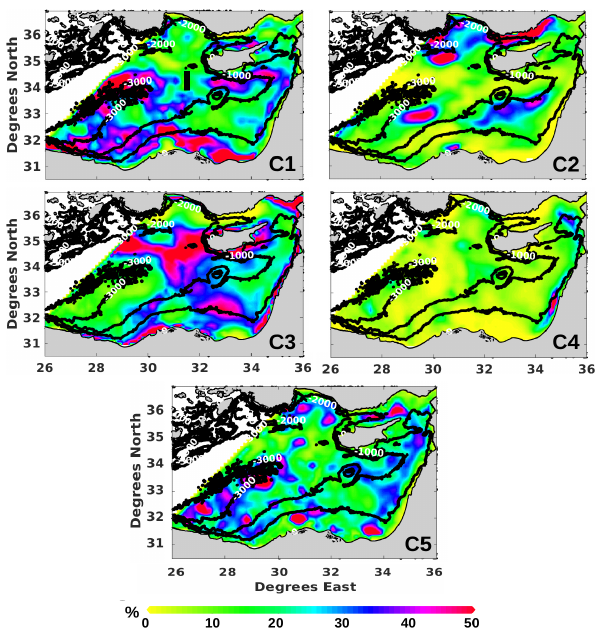
Figure 7. Percentage of C1, C2, C3, C4, and C5 occurrence between 1993 and 2018, superimposed onto the main bathymetric iso-lines of − 1000, − 2000, and − 3000m. The dark line in the C1 subplot shows the position of the Hovmöller diagram in Sect. 3.3.